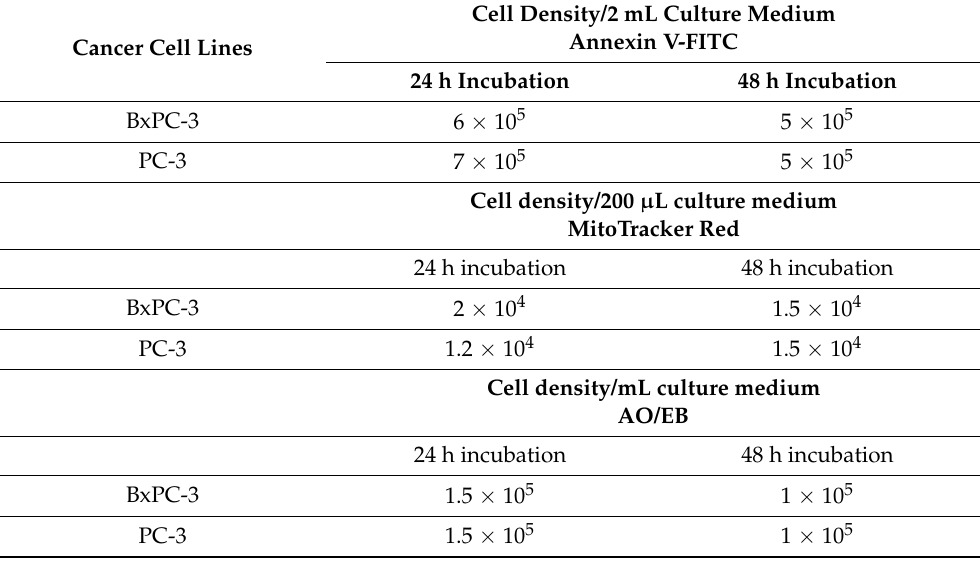
Table 9. Density of BxPC-3 and PC-3 cells used in the experimental series in Annexin V-FITC staining (the white panel), MitoTracker Red (the yellow panel) and dual acridine orange/ethidium bromide fluorescent staining (the grey panel).